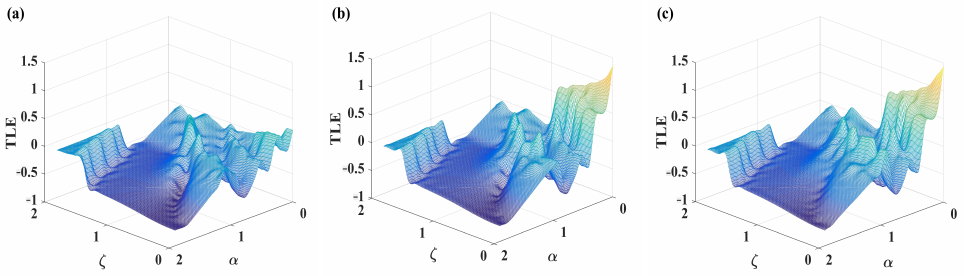
Figure 12. The TLE with the variation of damping coefficient ζ and electromechanical coupling coefficient α under different intensities. ( a ) σ = 0.0; ( b ) σ = 0.01; ( c ) σ =